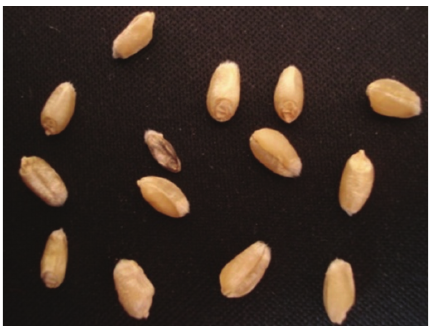
Figure 1: The original image of wheat seeds.